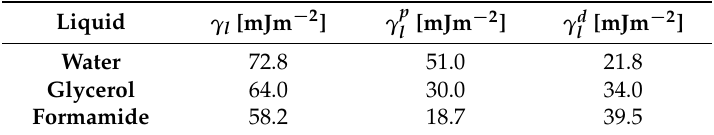
Table 3. Surface tension and its components for all liquids: water [59,60], glycerol [61,62], and formamide [62,63] used in contact angle